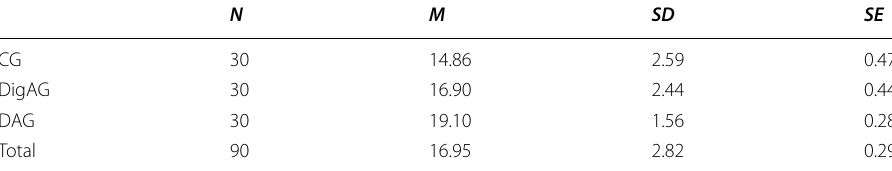
Table 3 Descriptive statistics of speaking fluency posttest of all